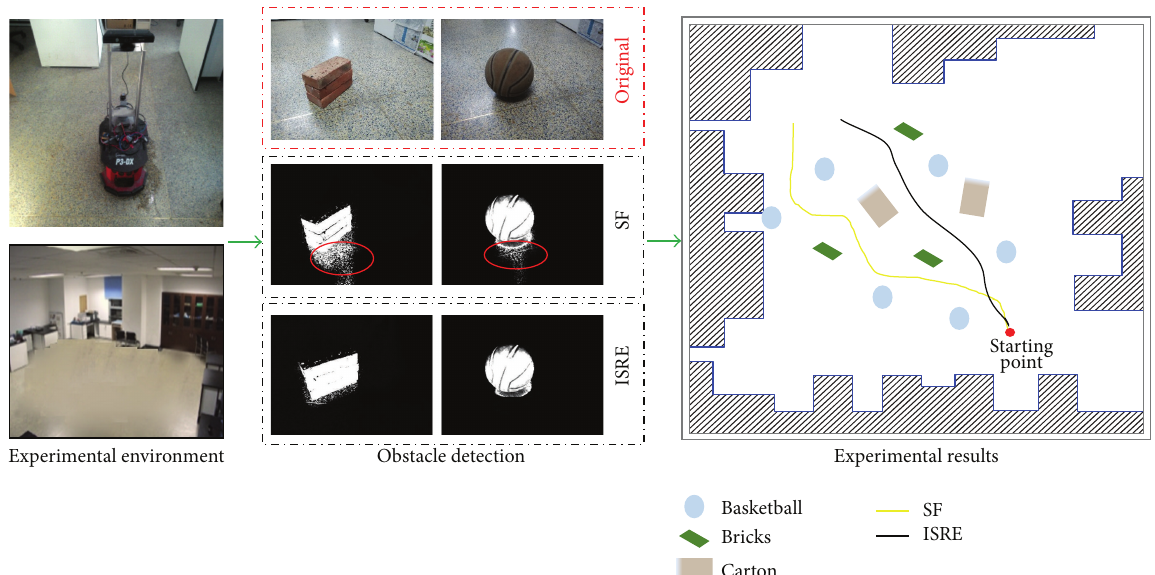
Figure 9: Contrast experiment results between our method and SF